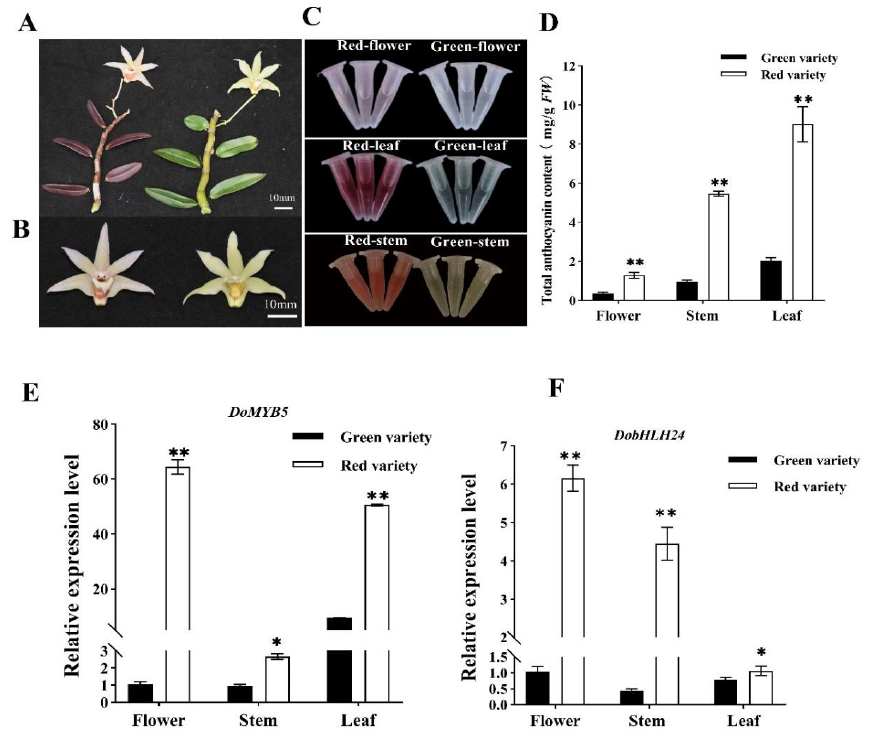
Figure 1. Anthocyanin content and relative expression level of DoMYB5 and DhbHLH24 in flower, stem, and leaf of red and green D. officinale varieties. ( A , B ) Photographs of red and green D. officinale varieties. ( C , D ) Anthocyanin extracts from the flower, stem, and leaf of red and green D. officinale varieties. ( E , F ) DoMYB5 and DhbHLH24 expression levels in the flower, stem, and leaf of red and green D. officinale varieties were measured using qRT-PCR. * Significant difference ( p < 0.05). ** Extremely significant difference ( p < 0.01).